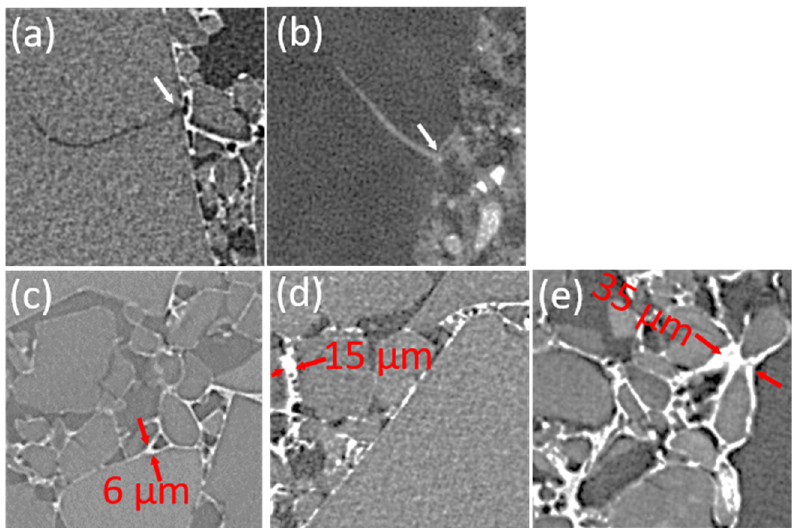
Figure 8. 200 × 200 cross-section in the X-ray tomogram, microstructure details. ( a ) organic binder wrapping aerogel particles without binder intrusion inside aerogel particle cracks and fracture lines; ( b ) mineral binder filling space between aerogel particles, and also filling aerogel particle cracks and fracture lines; ( c ) organic binder T, ESRF, low thickness binder skin, and adhesive contact between particles; ( d ) organic binder X, — few medium thickness binder skins, including aligned air bubbles. ( e ) organic binder X, — numerous large thickness binder skins and regular thickness skins showing disrupted adhesion to particles and large air gaps in between. White arrows show crack openings, and red double arrows measure binder thickness perpendicular to aerogel particles.